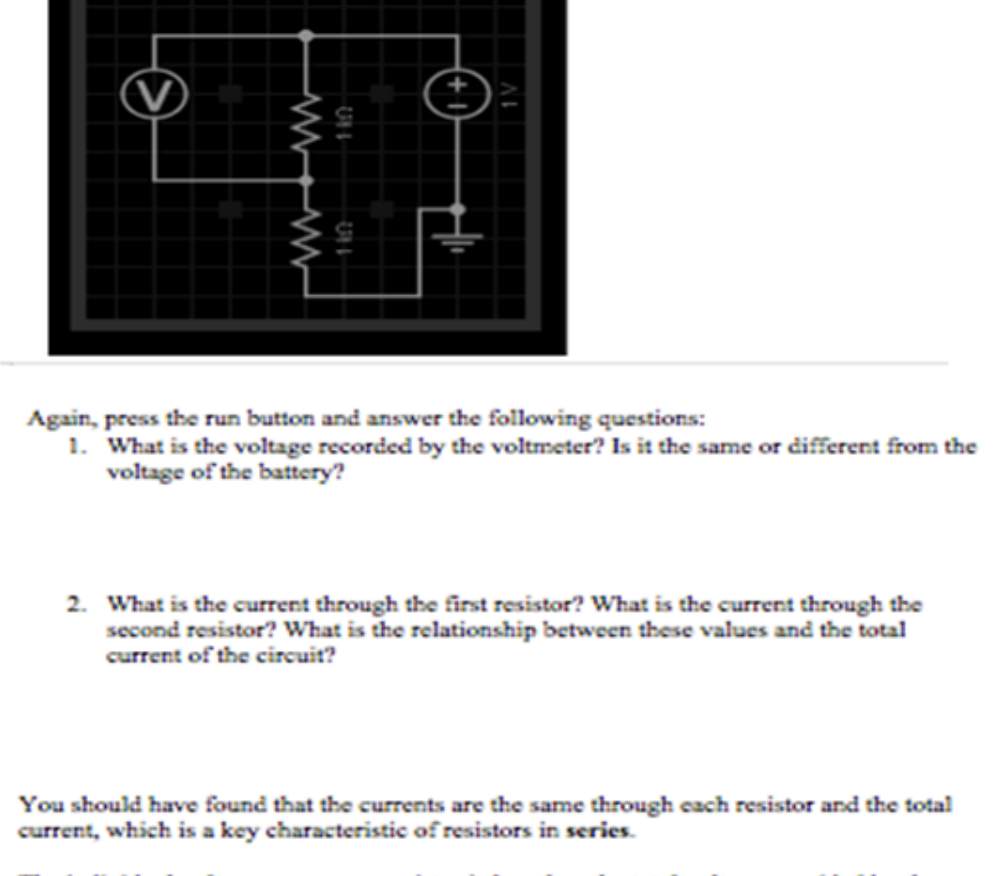
Figure 3. Basic format given to all of the students for series circuits